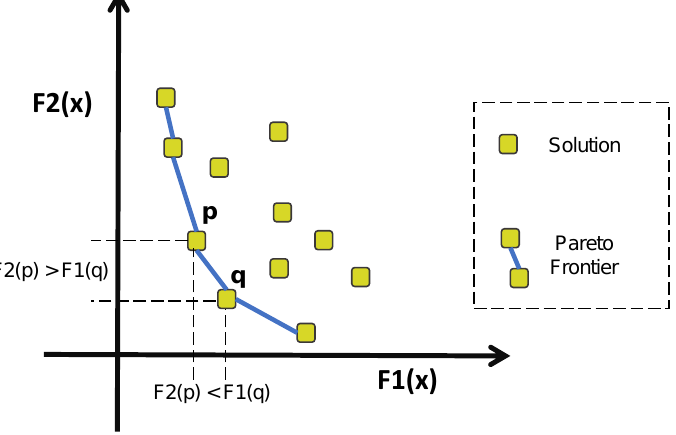
Figure 2. Illustrative example of a Pareto Frontier for a two-objective problem [32].